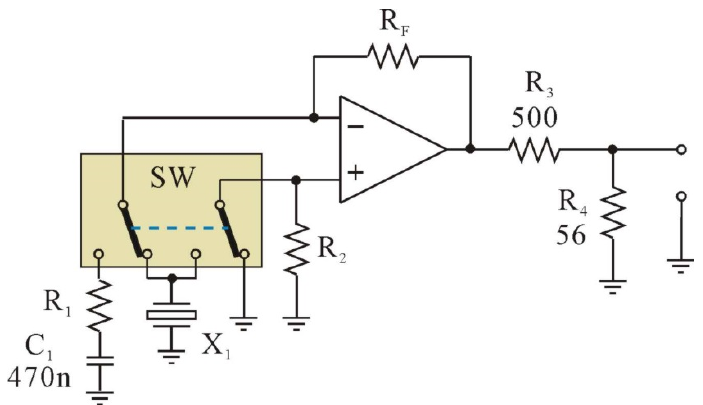
Figure 2. Circuit diagram of the tested preamplifier.